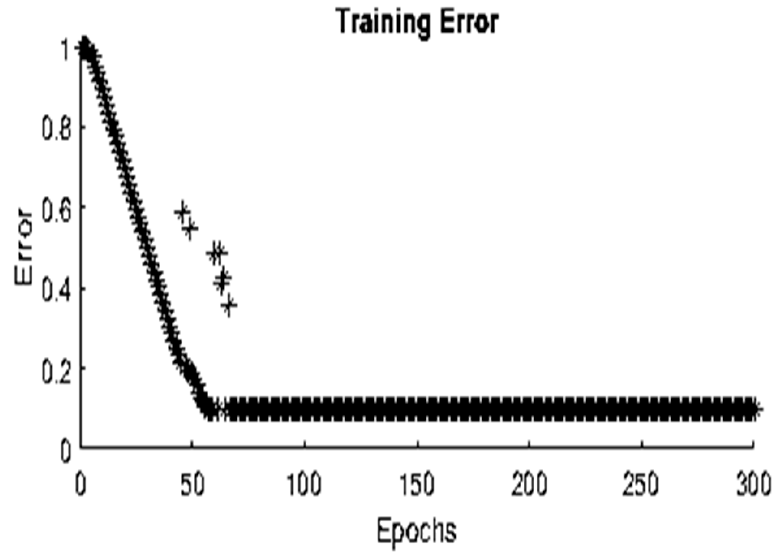
Figure 16. Training error curve of proposed ANFIS control for heading plane.